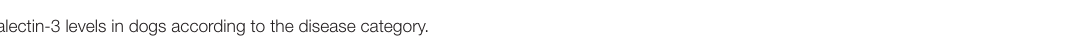
TABLE 2 | Galectin-3 levels in dogs according to the disease category.